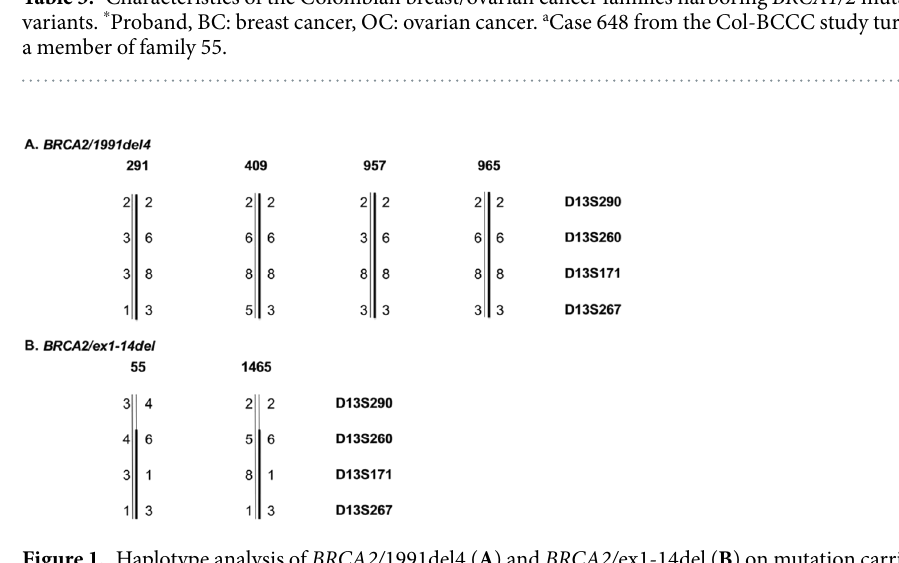
Figure 1. Haplotype analysis of BRCA2/ 1991del4 ( A ) and BRCA2/ ex1-14del ( B ) on mutation carriers at four microsatellite BRCA2 flanking loci. Family numbers are given above the haplotype. Alleles are coded by numbers. D13S290: allele 2 (CA) 12 , allele 3 (CA) 13 , allele 4 (CA) 14 ; D13S260: allele 3 (CA) 20 , allele 4 (CA) 21 , allele 5 (CA) 22 , allele 6: (CA) 23 ; D13S171:allele: 1 (CA) 13 , allele 3 (CA) 15 , allele 8 (CA) 20 ; D13S267: allele 1 (CA) 32 , allele 3 (CA) 34 , allele 5 (CA) 36 . Common haplotypes are indicated by a bold